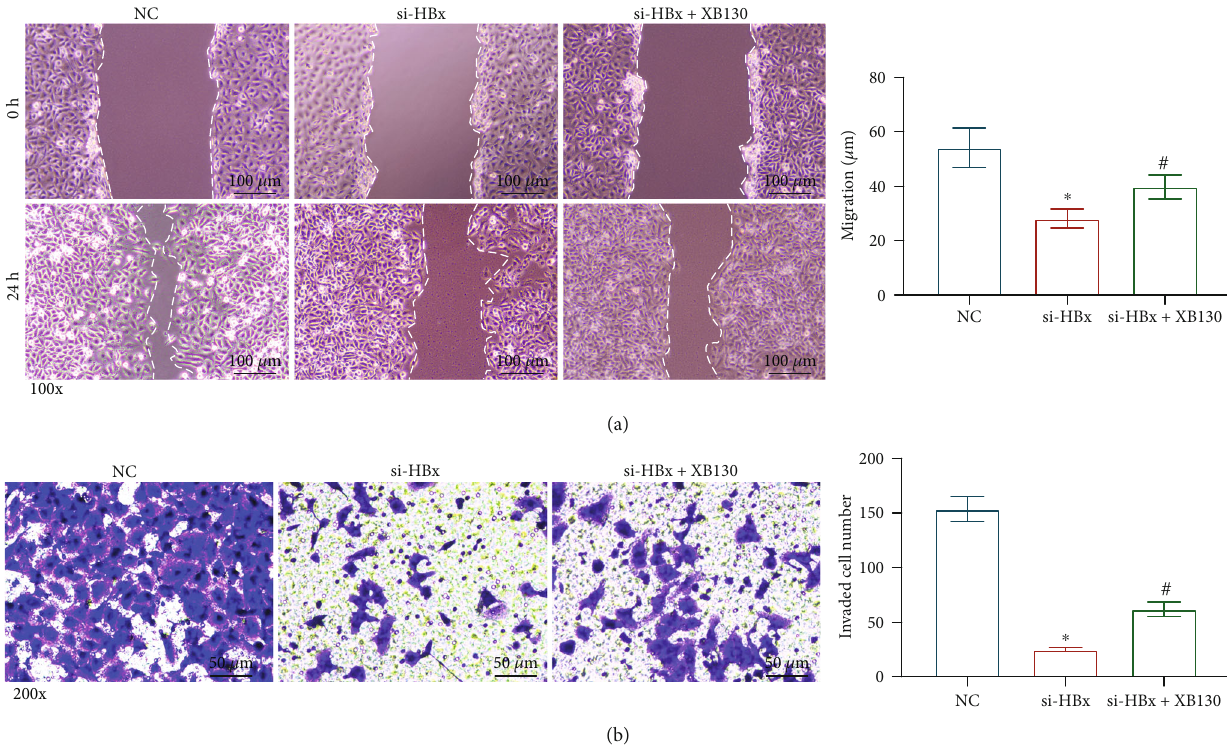
Figure 5: HBx promotes migration/invasion of HepG2 cells by upregulating XB130. (a) Cellular migration assessed by wound healing assays. (b) Number of invasive cells determined by Transwell assay. ∗ # p < 0 : 05 .